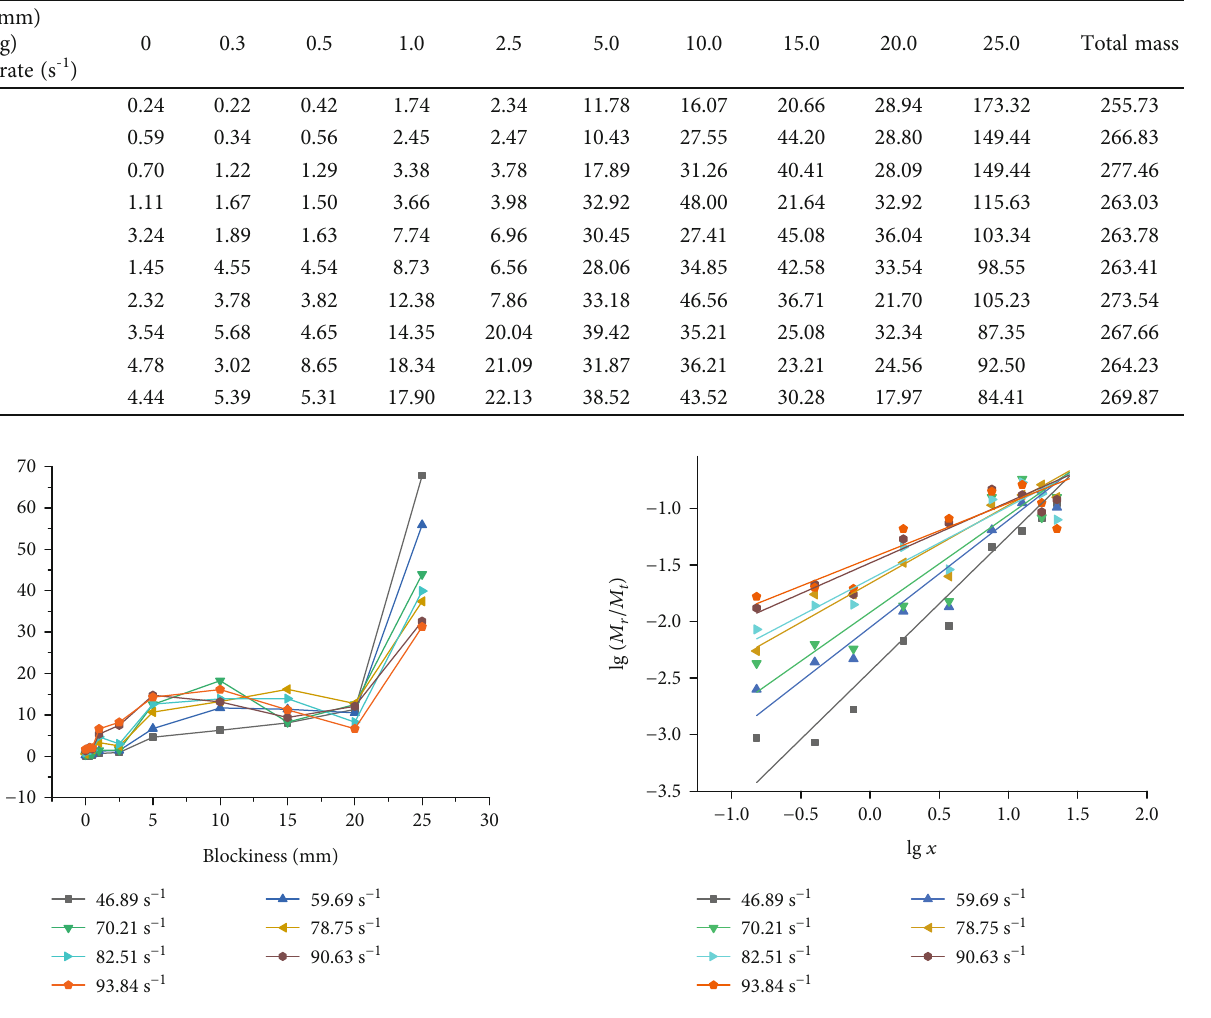
Figure 5: Distribution of fragmentation bulkiness of pomegranate biotite schist at di ff erent strain rates.